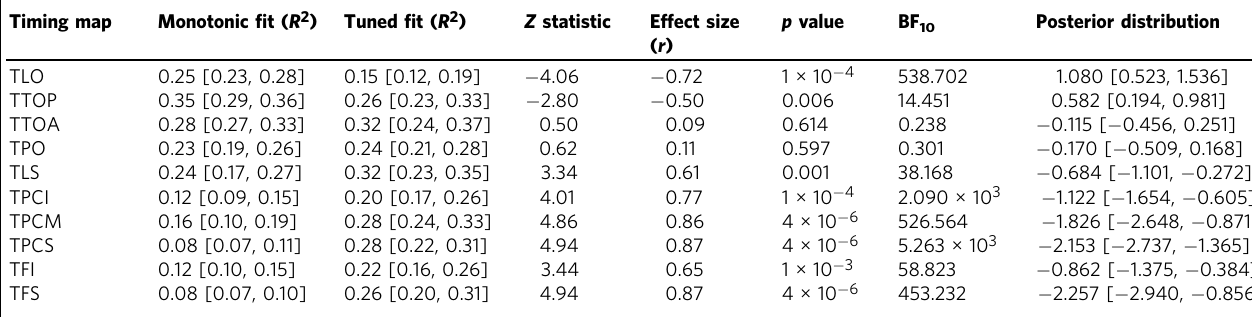
Table 3 Descriptive and test statistics of the paired model comparisons within timing